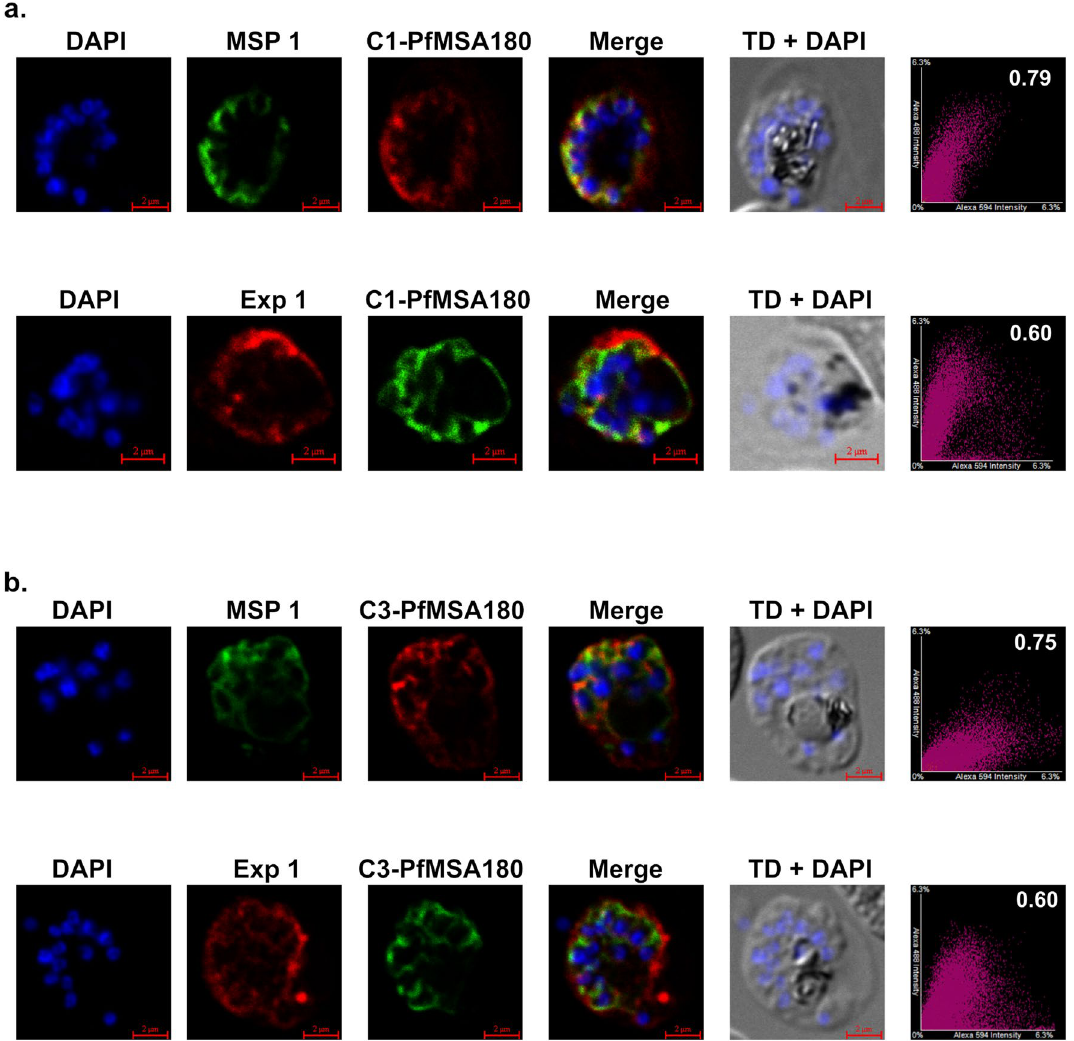
Figure 3. Immunofluorescence microscopy showing co-localisation of PfMSA180 with MSP-1 within mature schizonts. ( a ) Immunofluorescence detection of antibodies to C1 (N-terminus of PfMSA180) showing areas of co-localisation with MSP1 antibodies. Upper panel C1-PfMSA180 (Red), MSP1 (Green). Second panel C1-PfMSA180 (Green), Exp1 (Red). ( b ) Immunofluorescence detection of antibodies to C3 (C-terminus of PfMSA180) showing areas of co-localisation with MSP1 antibodies. Upper panel C3-PfMSA180 (Red), MSP1 (Green). Second panel C3-PfMSA180 (Green), Exp1 (Red). MSP1 is a merozoite surface protein and Exp1 (Exportin 1) is a parasitophorous vacuole membrane marker protein. The first column shows DAPI (4 ′ ,6-diamidino-2-phenylindole) DNA-stained schizonts, the second column shows the staining observed with marker antibodies, the third column displays PfMSA180 antibody staining, the fourth column is a merged image of the antibody staining, and the fifth column shows the transmitted image (TD) together with DAPI staining. The last column is the graph for antibody staining to represent Pearson’s correlation coefficient for co-localisation. The correlation coefficient is a measure of signal intensities of the two fluorophores in one image and the magnitude of the coefficient predicts the spatial relationship of the two fluorophores. A value close to zero indicates no correlation between the two fluorophores, while a value close to 1 indicates a positive correlation between the two fluorophores 42 . Five images were captured for each antibody combination and correlation coefficient values for colocalisation of anti-MSA180 (C1, C3) with anti-MSP1 ranged from 0.75– 0.79, while the correlation coefficient of anti-MSA180 (C1, C3) with anti-Exp1 ranged from 0.56–0.60. One image for each antibody combination is displayed